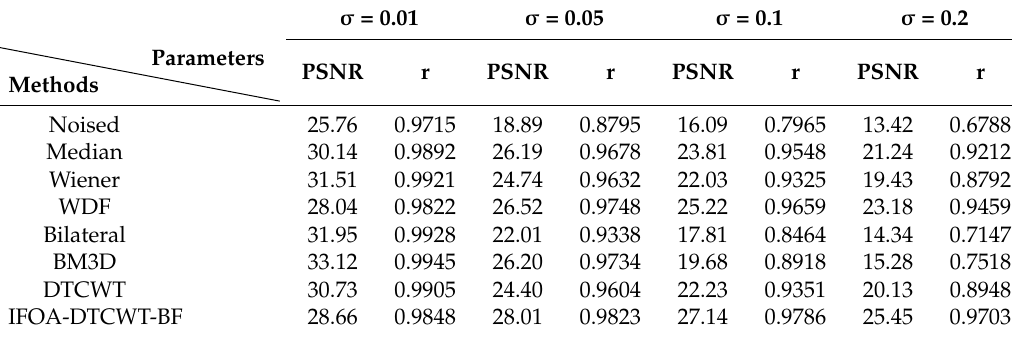
Table 7. Comparison of the six methods (Peppers with Speckle